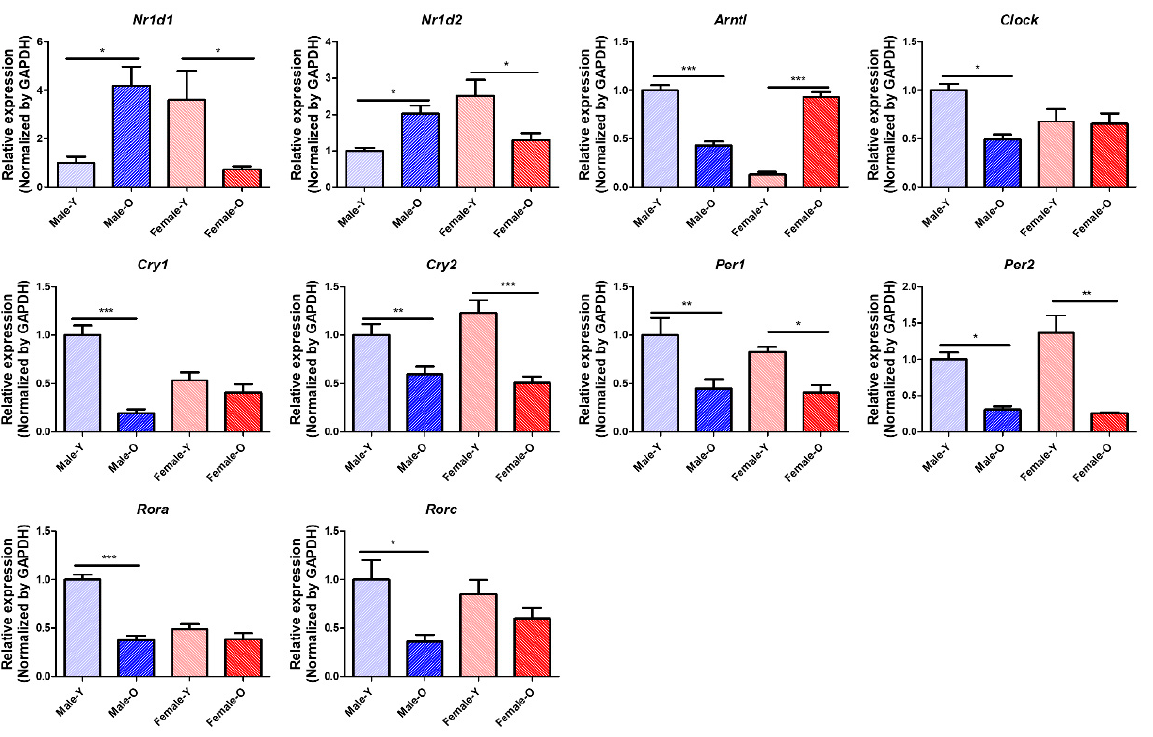
Figure 4. Relative mRNA expression of circadian genes differentially expressed across sex and age in SD rats ( n = 6 per group). Nr1d1 , Nr1d2 , Arntl , Clock , Cry1 , Cry2 , Per1 , Per2 , Rora , and Rorc showed sex differences in their gene expression during liver aging. Nr1d1 , nuclear receptor subfamily 1